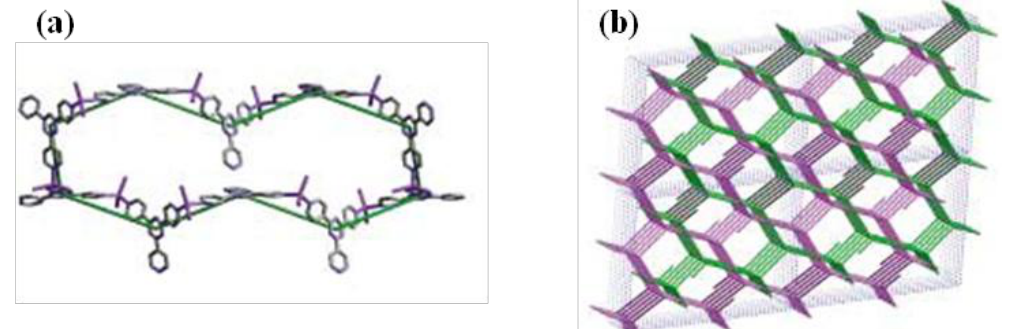
Figure 5. Schematic drawing of SCSC of {(ZnI of nitrobenzene as the guest molecules. The contraction of unit cell volumes is viewed along the (100) direction. Reprinted with permission from [23]. Copyright © 2002 WILEY-VCH Verlag GmbH & Co. KGaA,